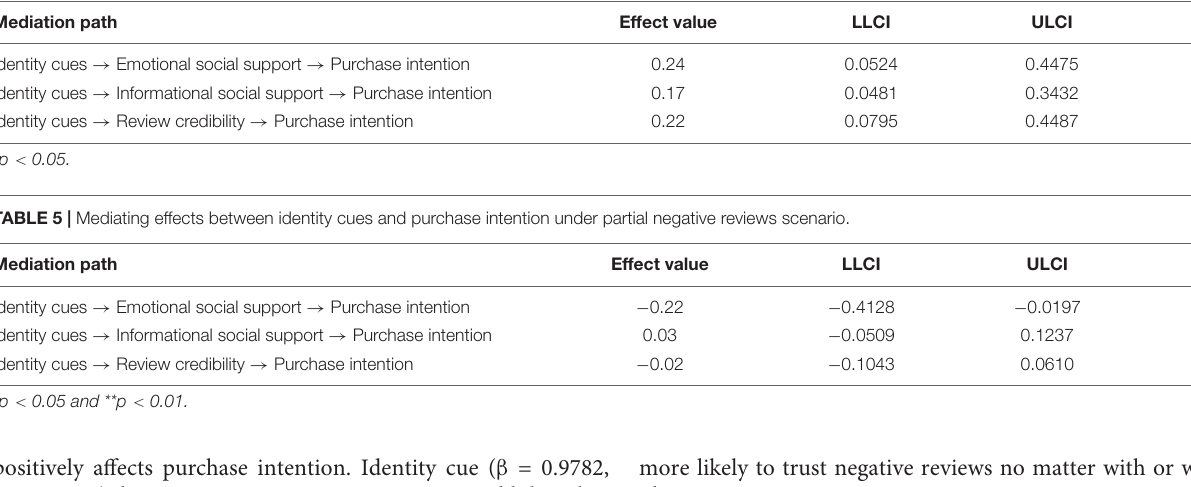
FIGURE 1 | Comparison of purchase intentions after reading product reviews. TABLE 4 | Mediating effects between identity cues and purchase intention under all positive reviews scenario.